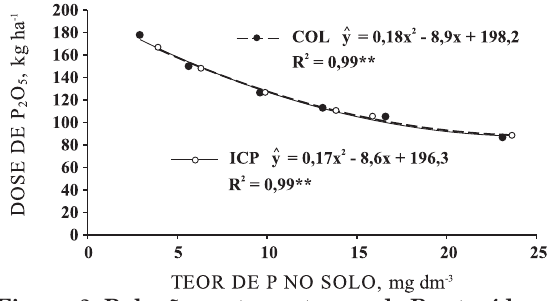
Figura 3. Relações entre os teores de P extraído pela solução de Mehlich-1, determinado por colorimetria (COL) e por ICP, e as doses de P recomendadas para o milho (para uma expecta- tiva de rendimento de 8,0 t ha -1